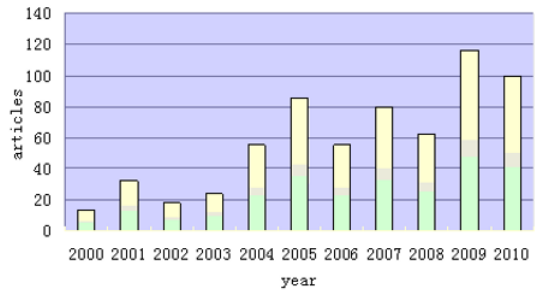
Figure 1. The numbers of published articles about HSCCC per year (2000-2010) on account of Scifinder Scholar